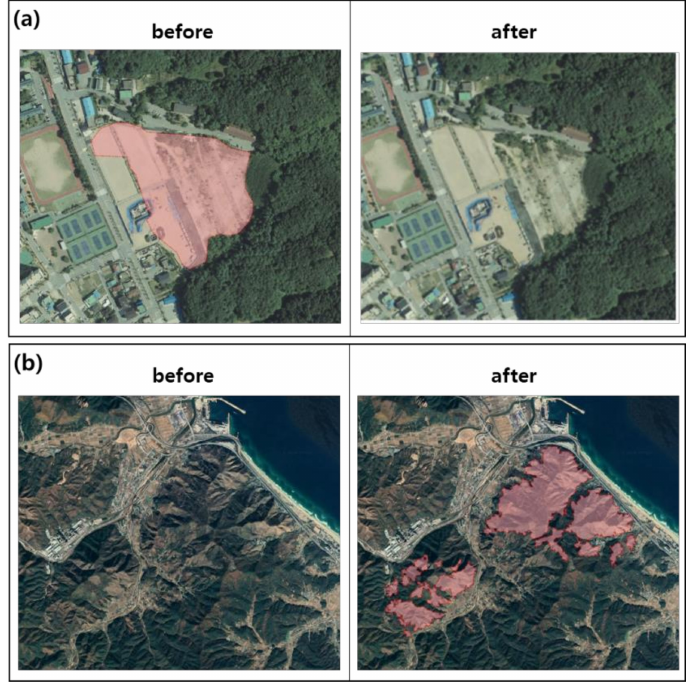
Figure 3. Examples of polygon modification: ( a ) excluding the developing areas; ( b ) modifying the area damaged by forest fire for accurate area